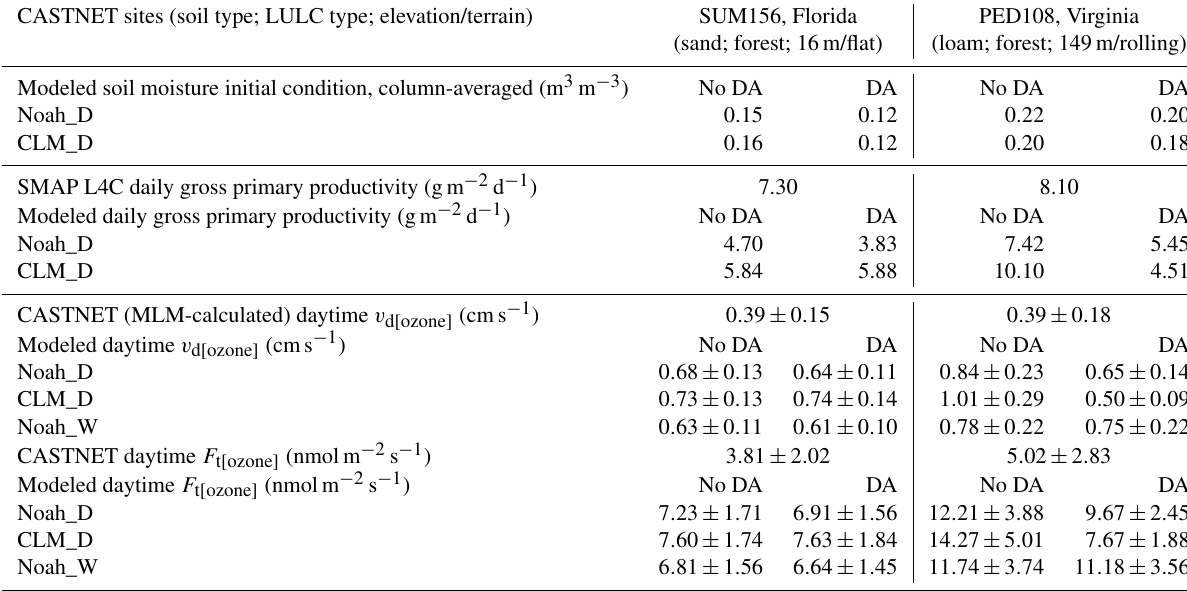
Table 6. Period-mean (16–28 August 2016) soil moisture and surface fluxes at two CASTNET sites shown in Fig. 1d. Standard deviations calculated based on the hourly O 3 dry-deposition velocity v d [ ozone ] and flux F t [ ozone ] results are also included. Daytime is defined as approximately 08:00–19:00 local standard time. CASTNET sites (soil type; LULC type;